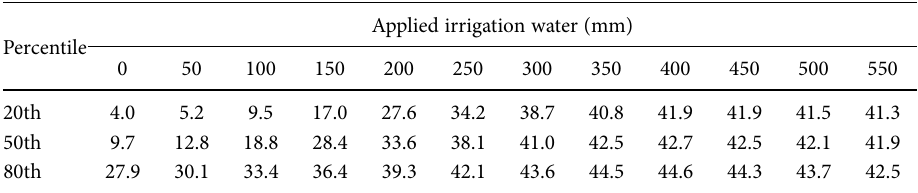
Table 4. Percentiles values from simulation for sugarbeet